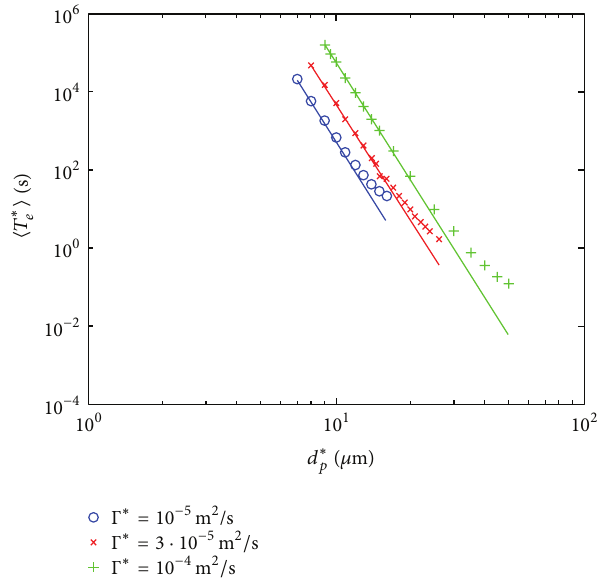
Figure 4: Average permanence time of particles inside an inclined vortex versus the particle diameter for various values of the circula- tion of the vortex and 𝑅 ∗ V = 0.001 m.